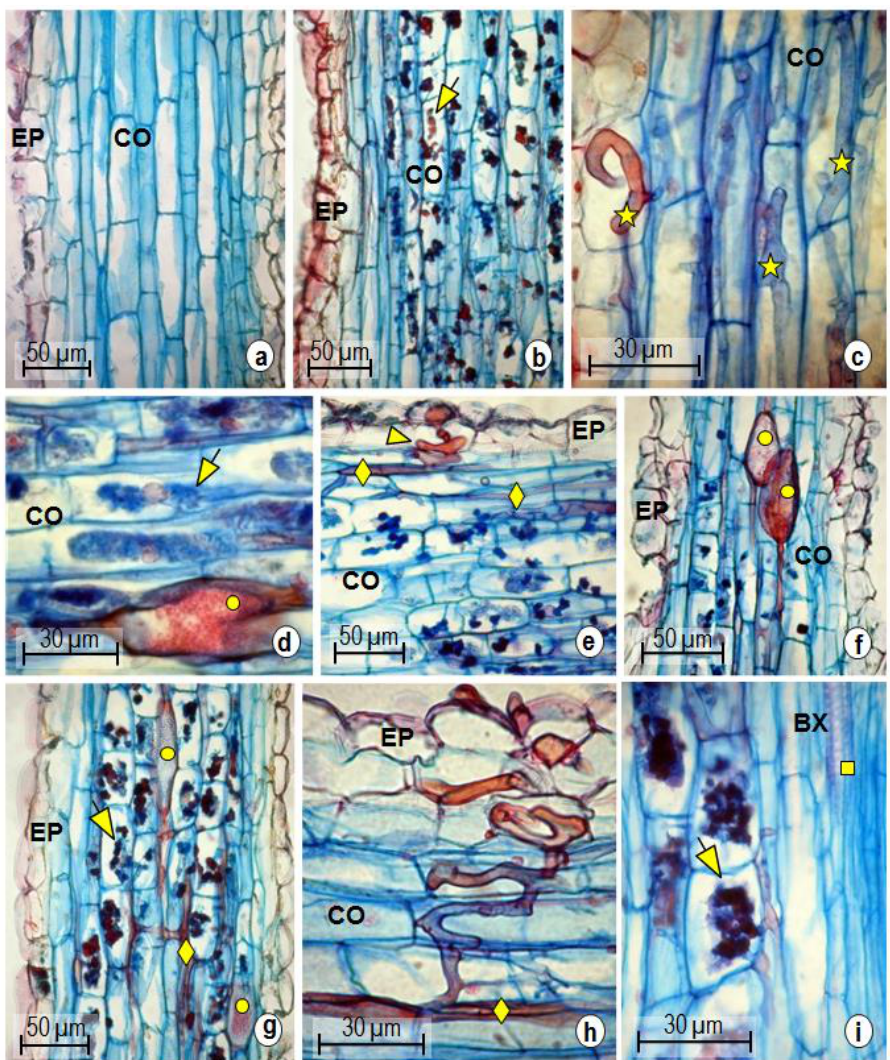
Figure 1. Longitudinal section of Piper nigrum roots colonized by arbuscular mycorrhizal fungi. ( a )